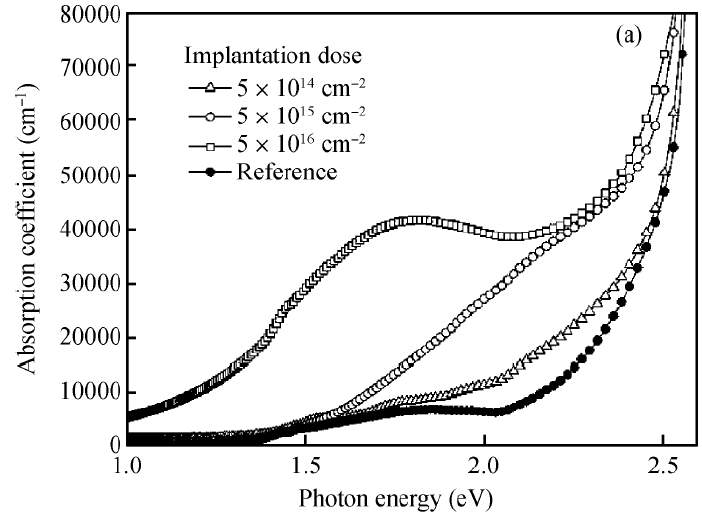
Figure 12. Adsorption spectra of different doses of N-doped Cu 2 O and undoped films obtained from experimental results. Reprinted from [116] with permission from the Institute of Physics (IOP) Publishing.